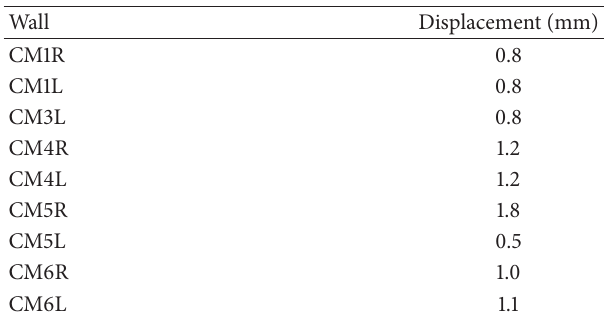
Table 1: Approximate deflections